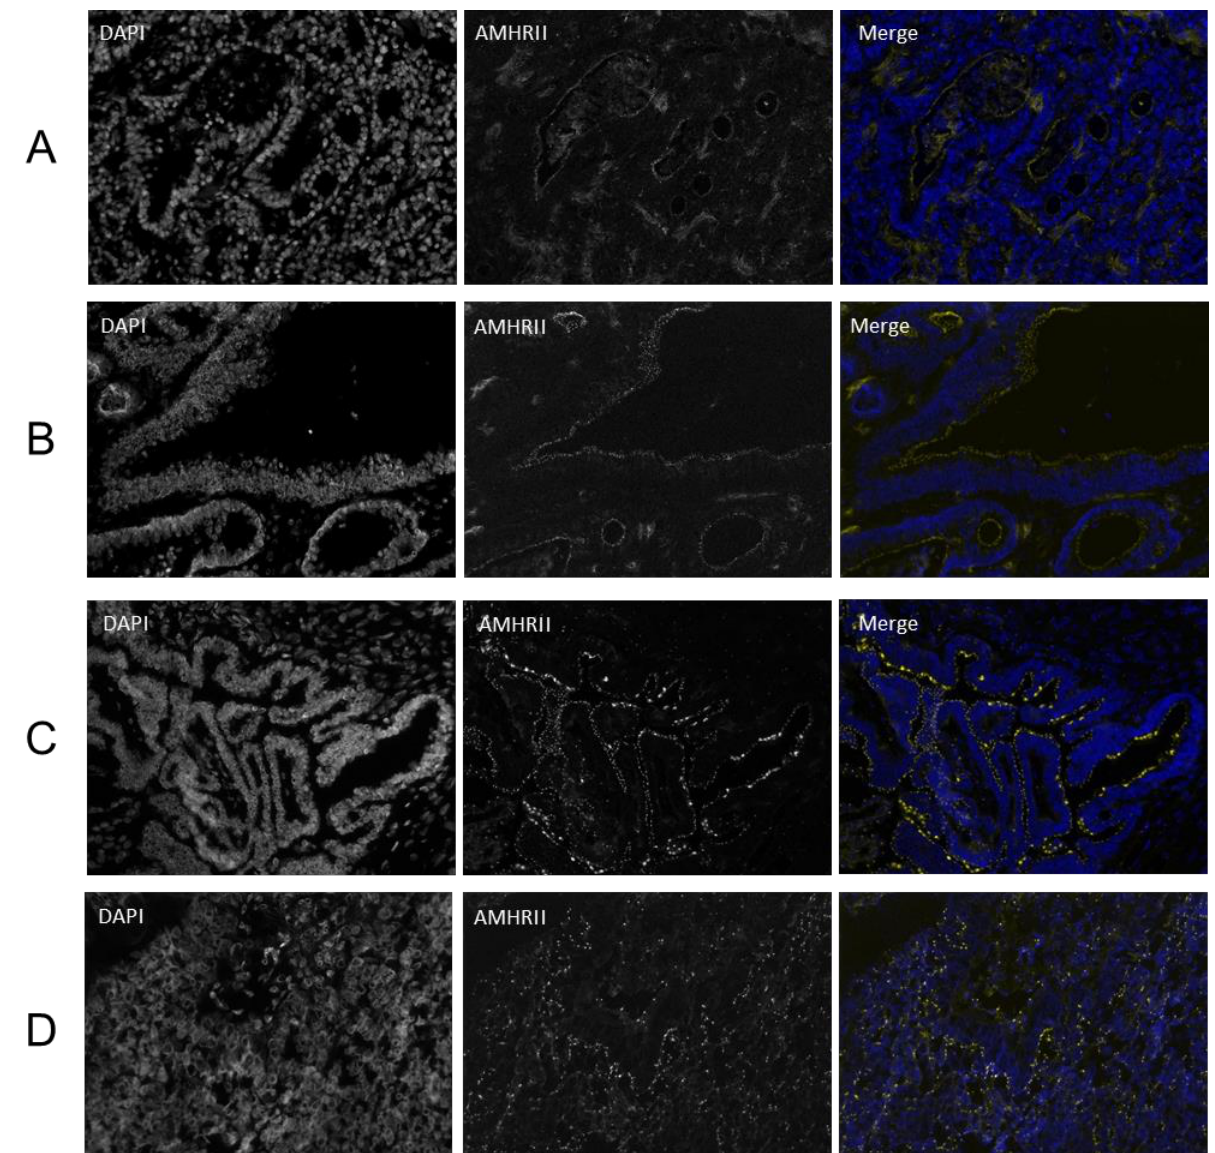
Figure 3. Immunofluorescence staining with murlentamab antibody of colorectal cancer (( A ): A3764 Tp2, ( B ): A3742 Tc15, patient biopsies), ovarian cancer (( C ): 1A717, ( D ): K583, patient biopsies). All fluorescent images were acquired with a widefield microscope DM5000 (Leica) with ×20 magnification. In Merge pictures, nuclear staining with DAPI was showed in blue and AMHRII staining with GM102 antibody was indicated in yellow.